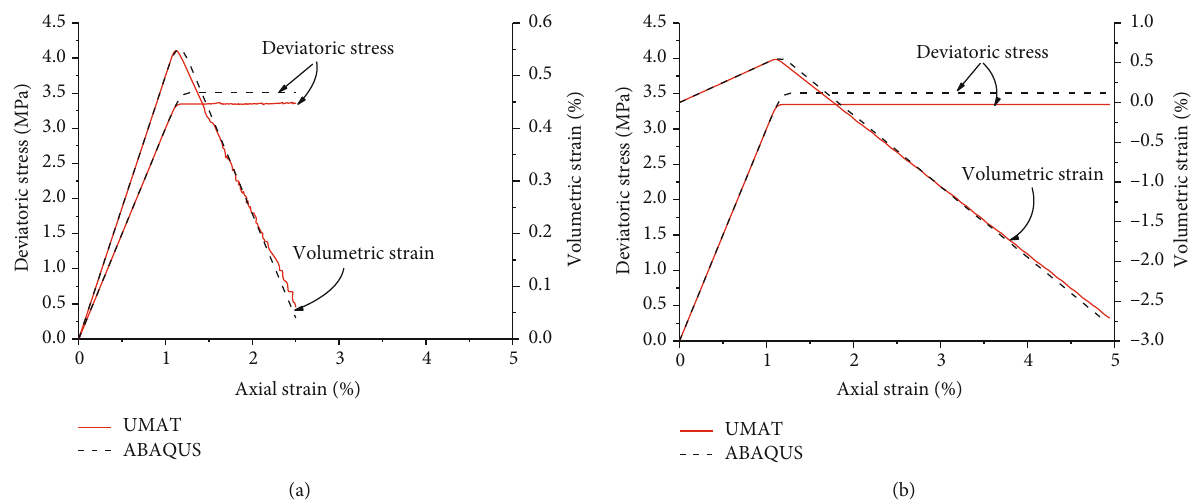
Figure 8: Stress-strain relationship under triaxial compression with a con fi ning pressure 3MPa: (a) nonassociated cases and (b) associated fl